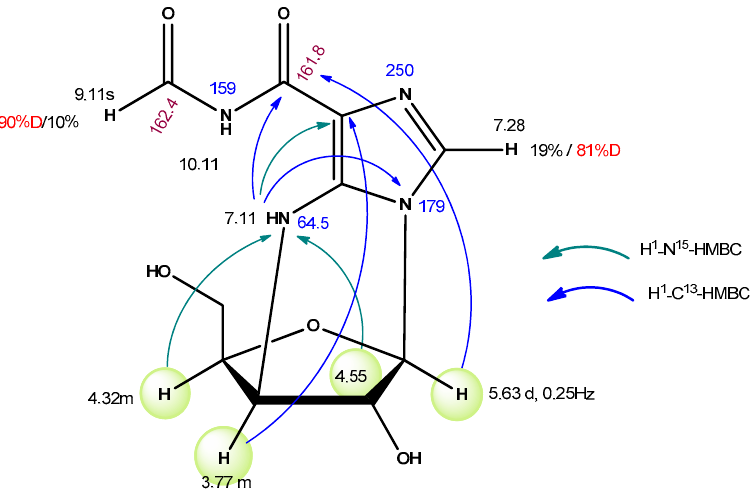
Figure 11. Assignments of main NMR signals for compound 14 .